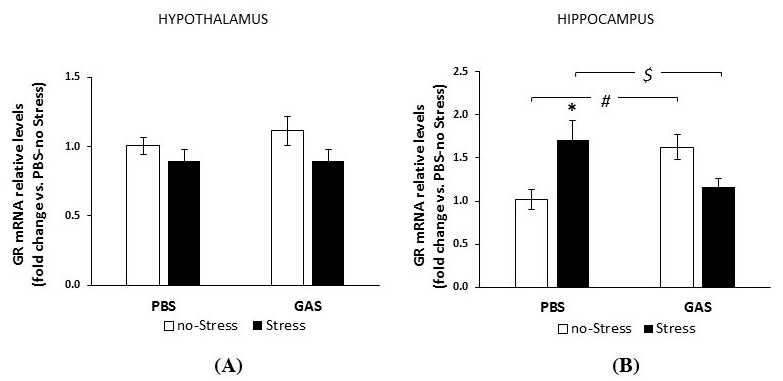
Figure 3. Glucocorticoid receptor (GR) mRNA expression in GAS-Stress mice and relative controls. RT-PCR were performed with mRNAs extracted from hypothalamus ( A ) and hippocampus ( B ) of control mice (PBS-no Stress), Group-A beta-haemolytic streptococcus injected mice (GAS-no Stress), psychosocial stressed mice (PBS-Stress), and mice exposed to haemolytic streptococcus and psychosocially stressed (GAS-Stress) at two weeks from treatment endings. Relative expression of GR mRNA in each area is presented as fold change over the expression measured in control mice (PBS-no Stress), taken as 1, and calculated using the 2- ΔΔ Ct method, normalized to hypoxanthine guanine phosphoribosyl transferase (HPRT), as detailed in the Materials and Methods section. Data are mean ± SEM, N= 4–6 per group. $ p < 0.05: GAS-Stress vs PBS-Stress; # p < 0.05: GAS-no Stress vs PBS-no Stress; * p < 0.05 PBS-no Stress vs. PBS-Stress. Cohen’s d measures are reported in Table S1A.